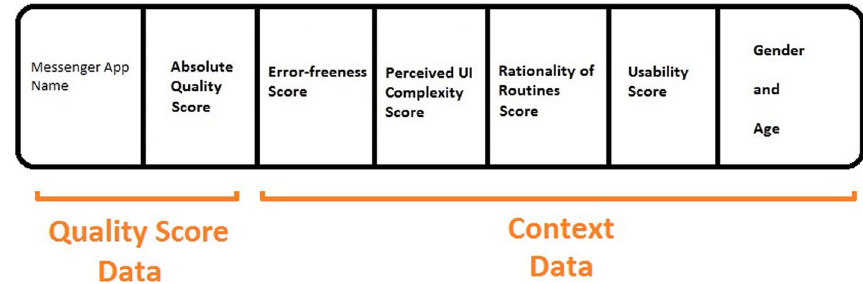
Fig. 11 The structure of a user opinion record